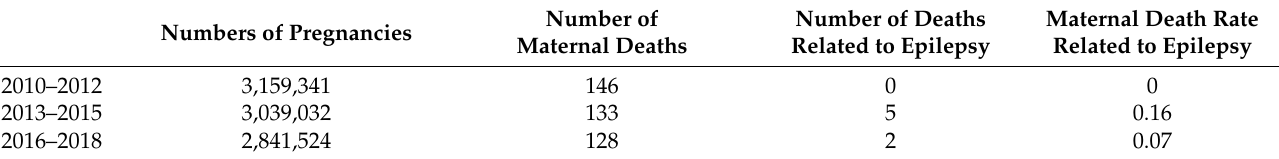
Table 1. The mortality related to epilepsy for the trienniums between and including 2010–2018 in